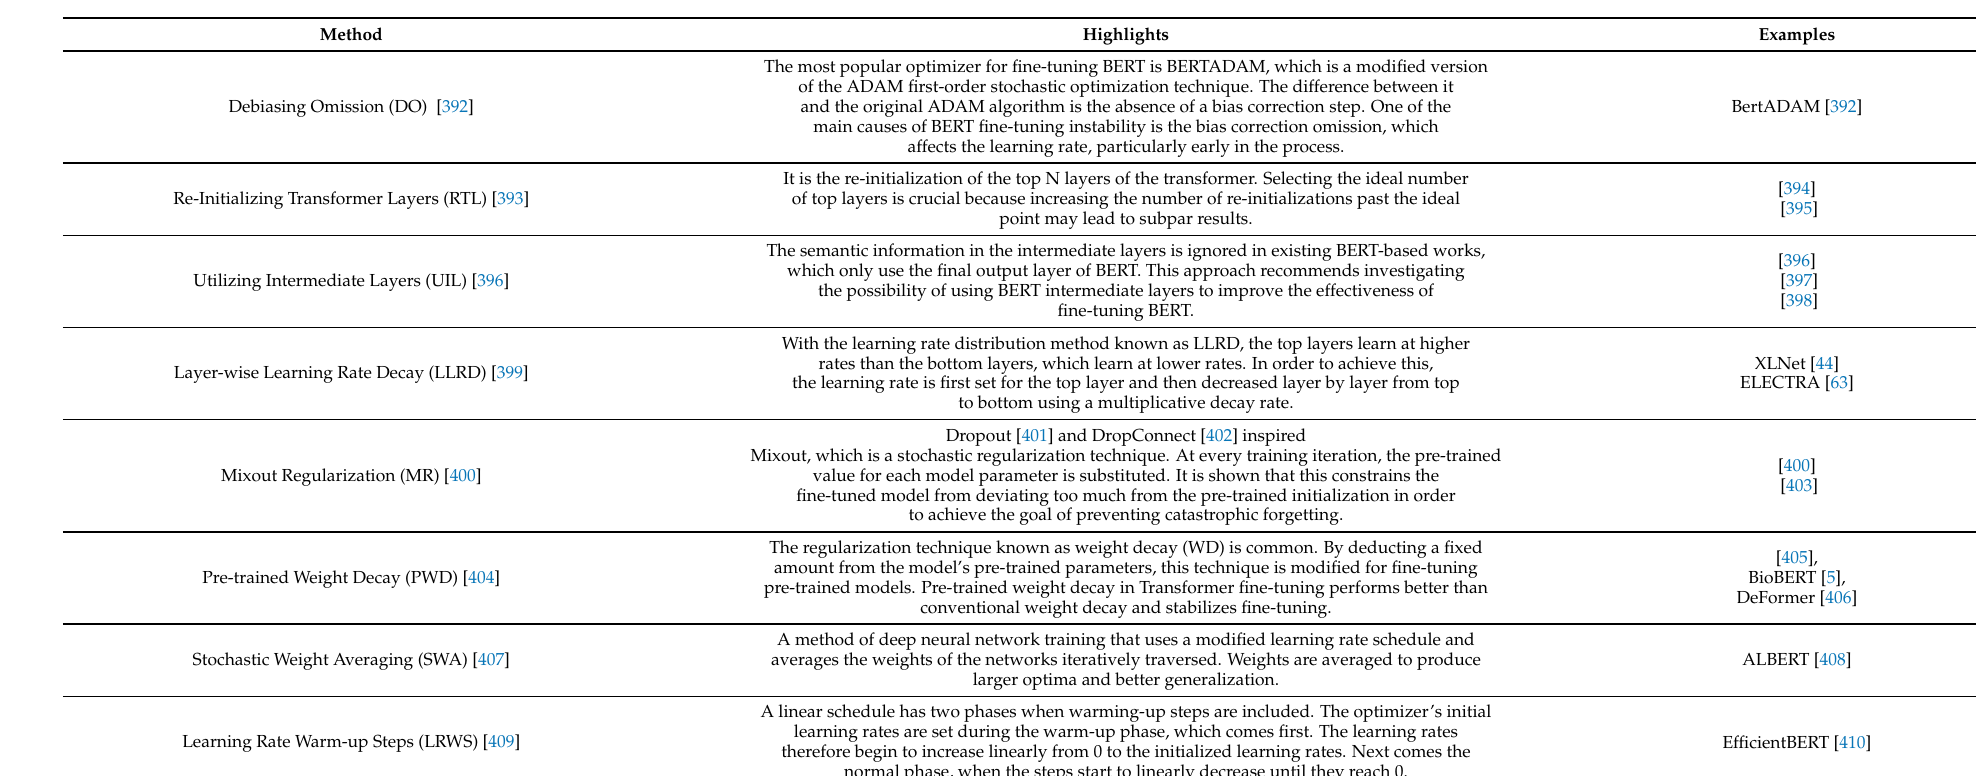
Table 7. List of methods to improve the fine-tuning phase for the TB